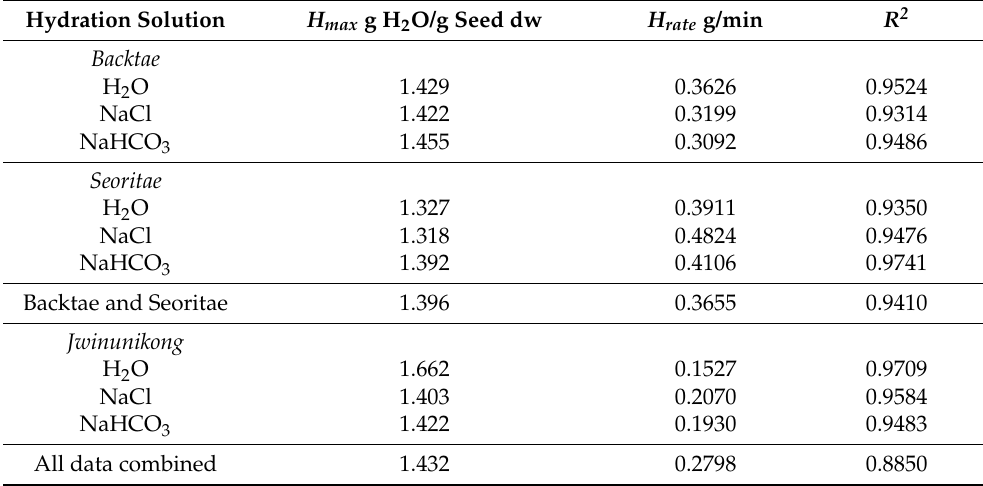
Table 3. Kinetic constants of the nonlinear regression analysis for soybean seeds